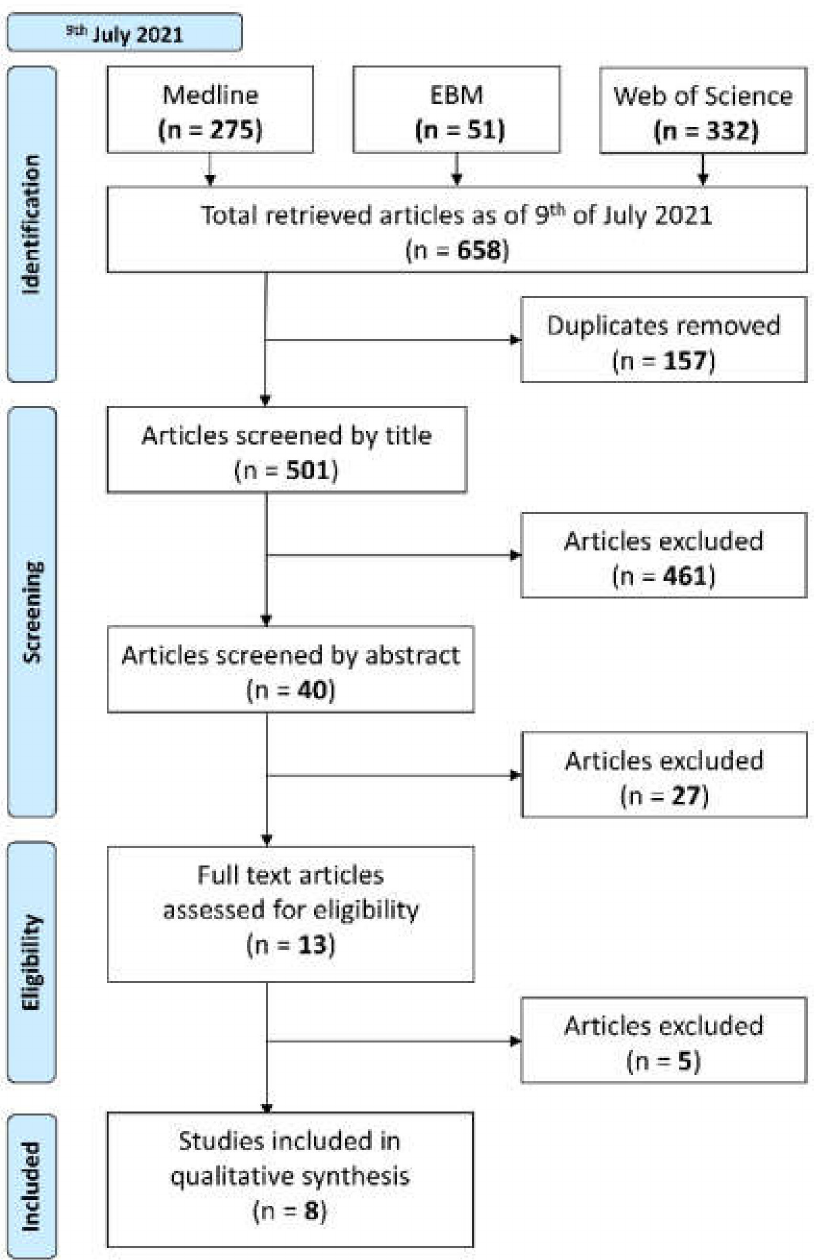
Figure 1. Selection of studies for the systematic review of milk-derived proteins and peptides in head and neck carcinoma